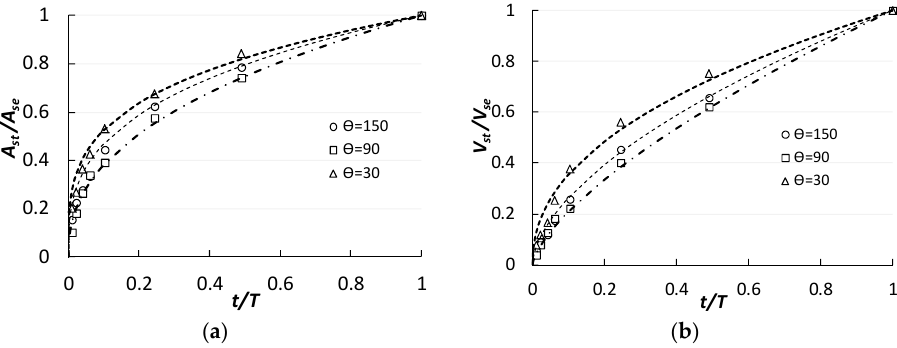
Figure 3. The evolution characteristics ( a ) the plane area of scour hole ( b ) scour hole-volume.